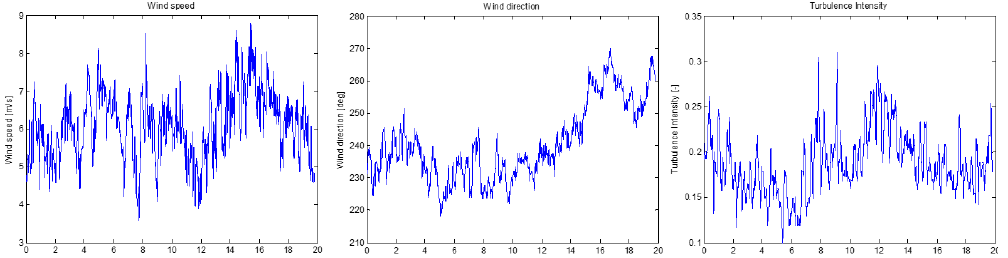
Figure 21. SCADA wind speed, direction and turbulence intensity used for simulation.